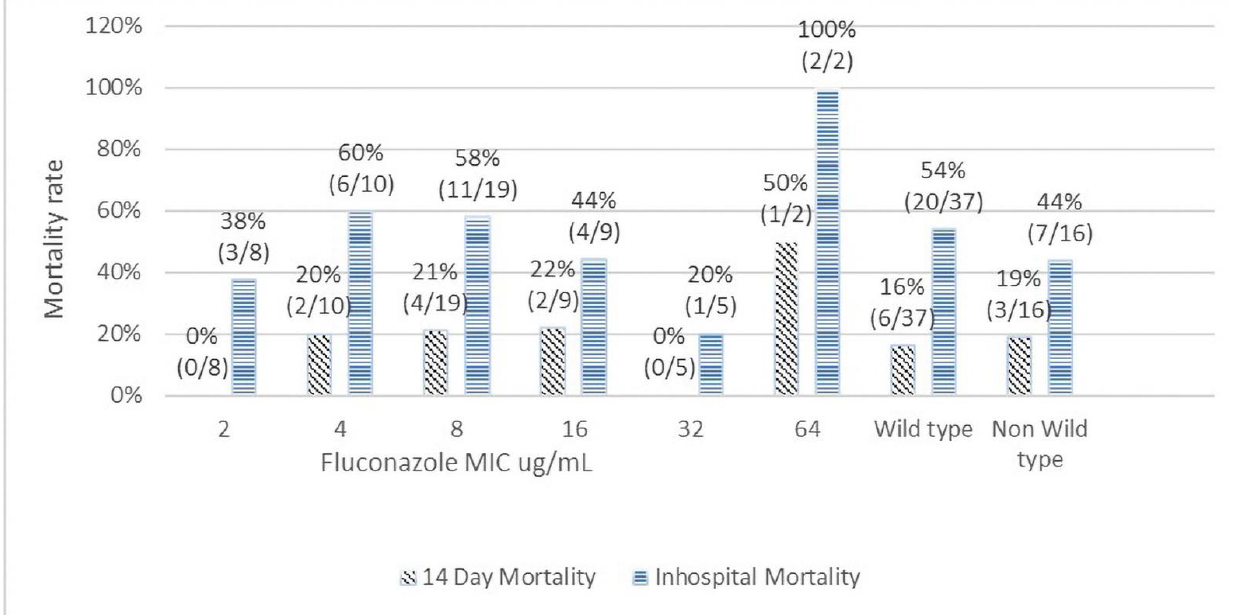
Figure 2. Correlation of fluconazole minimal inhibitory concentration with 14-day and in-hospital mortality.